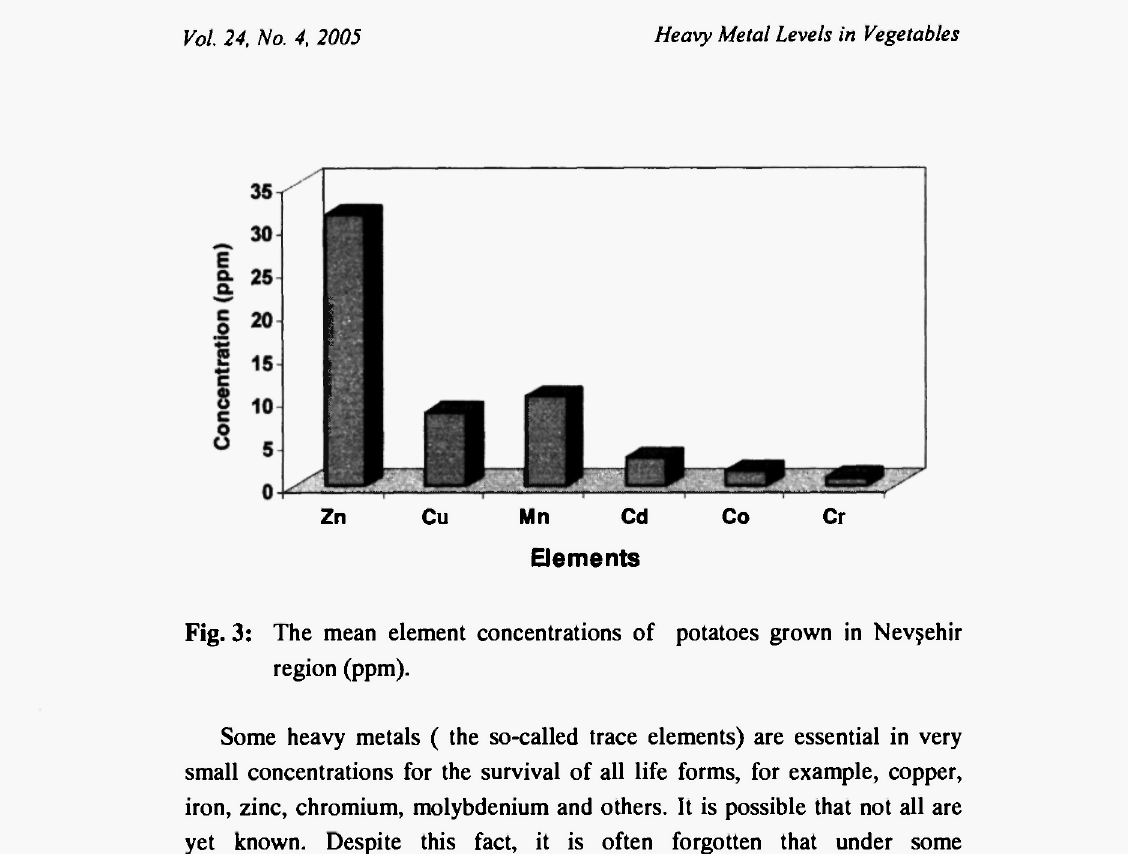
Fig. 3: The mean element concentrations of potatoes grown in Nevjehir region